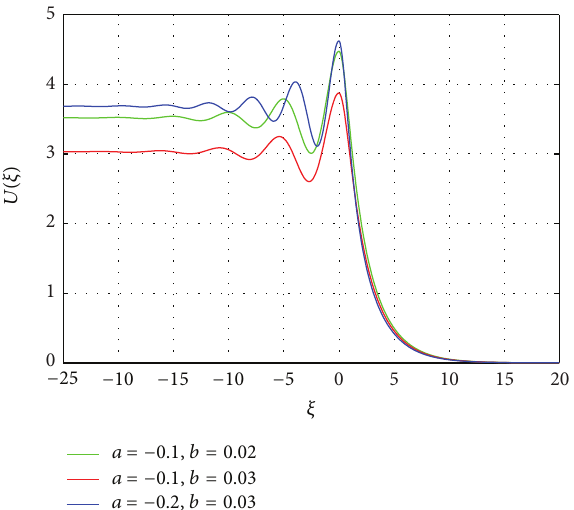
Figure 20: Plot of the approximate damped oscillatory solution (33) for different value of 𝑝 with 𝑎 = −0.2 , 𝑏 = 0.6 , 𝑐 = 0.2 , 𝛽 = 1 , and 𝑟 = −1 .